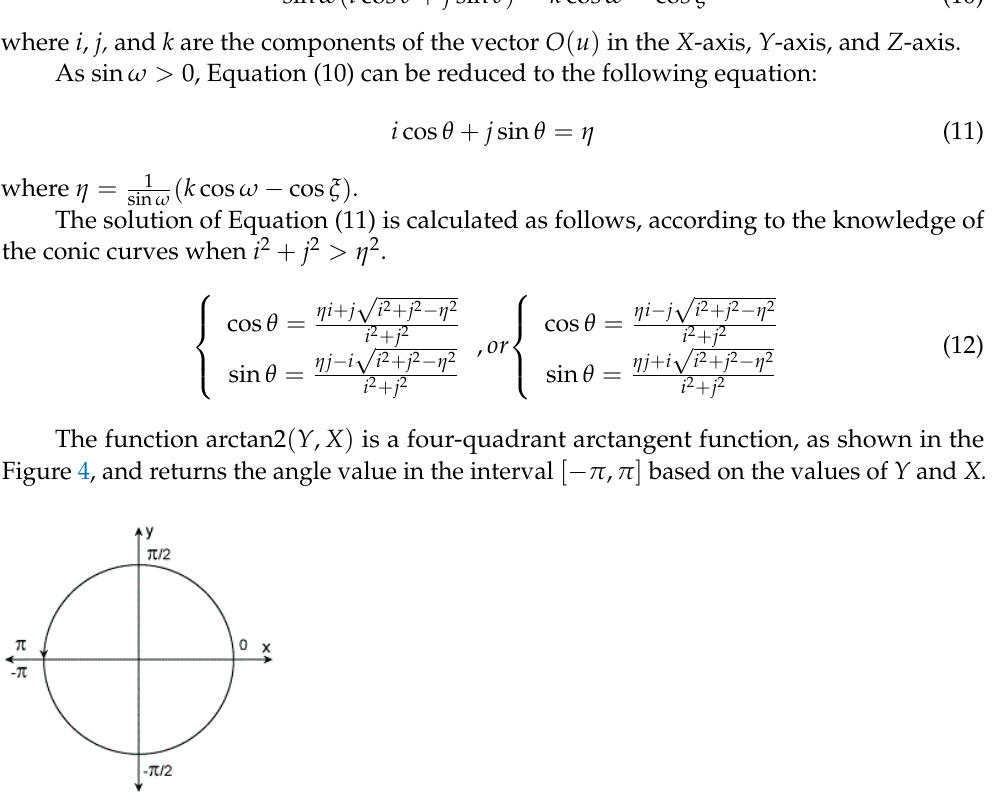
Figure 4. Value diagram of the four − quadrant arctangent function.